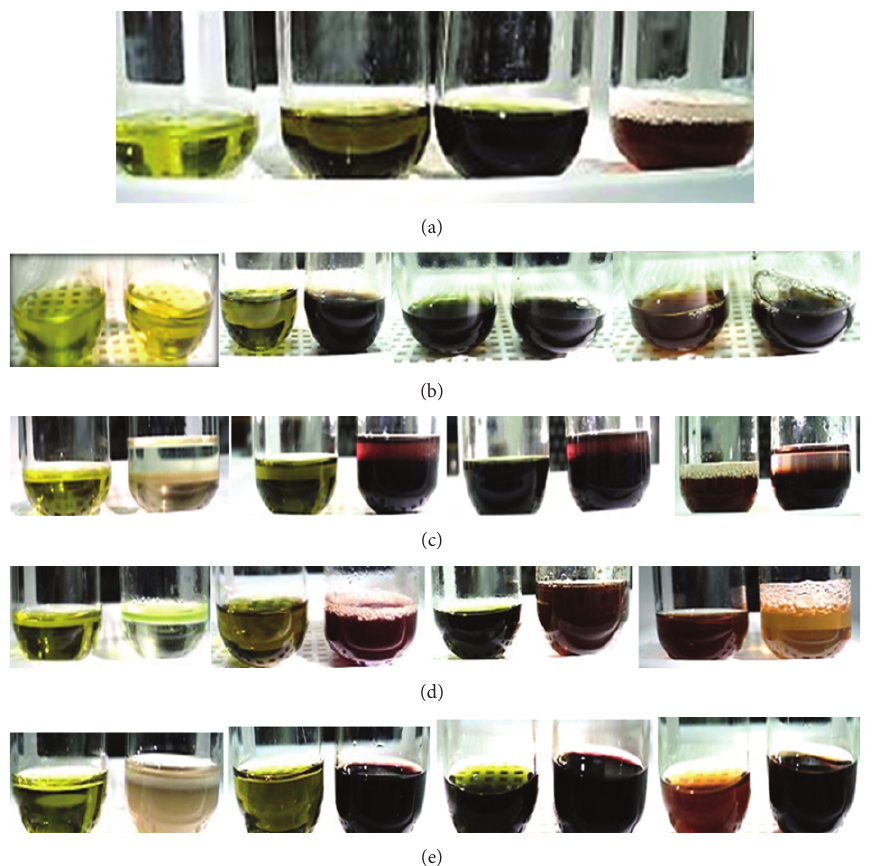
Figure 2: (a) Existence of saponin tests; L to R: n-hexane, methanol, ethanol, and distilled water extracts. (b) Existence of phenols and tannins tests; L to R: n-hexane, methanol, ethanol, and distilled water extracts. (c) Existence of terpenoids tests; L to R: n-hexane, methanol, ethanol, and distilled water extracts. (d) Existence of flavonoids tests; L to R: n-hexane, methanol, ethanol, and distilled water extracts. (e) Existence of glycosides tests; L to R: n-hexane, methanol, ethanol, and distilled water